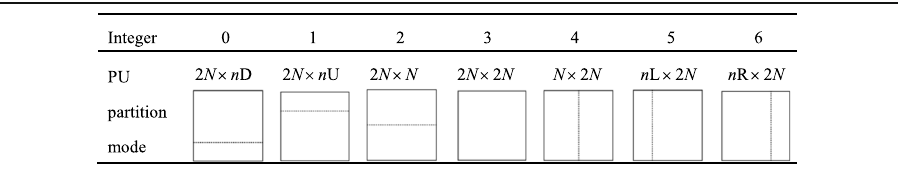
Table 9 Mapping 2 of PU partition modes for 16×16-sized CU